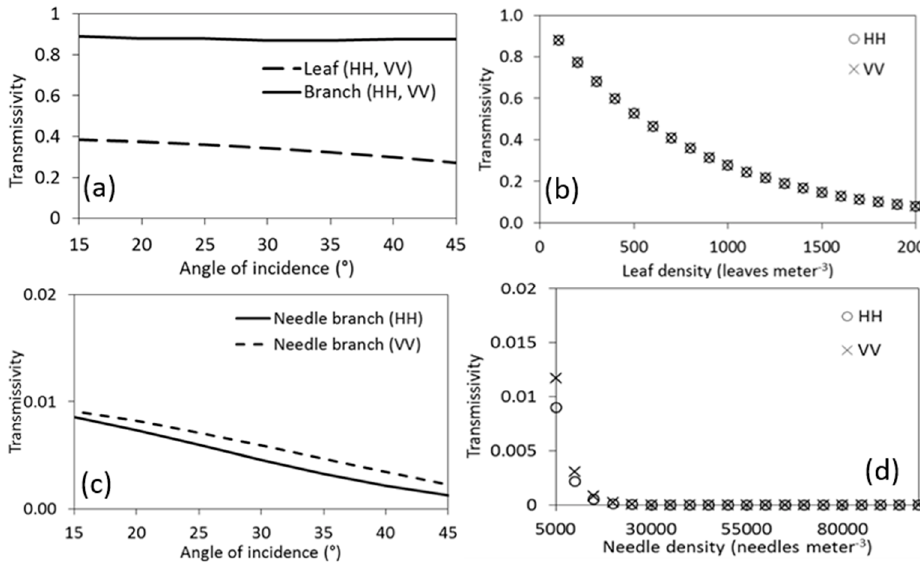
Figure 4. ( a , b ) HH, VV polarised crown transmissivity vs. scattering angle from 830 leaves per cubic meter and 4.1 branches per cubic meter and crown transmissivity vs. density of leaves at 30 scattering angle for Birch; ( c , d ) HH, VV polarised crown transmissivity vs. scattering angle from 85,000 needles per cubic meter and 3.4 branches per cubic meter and crown transmissivity vs. density of needles at 30 scattering angle for Norway spruce.